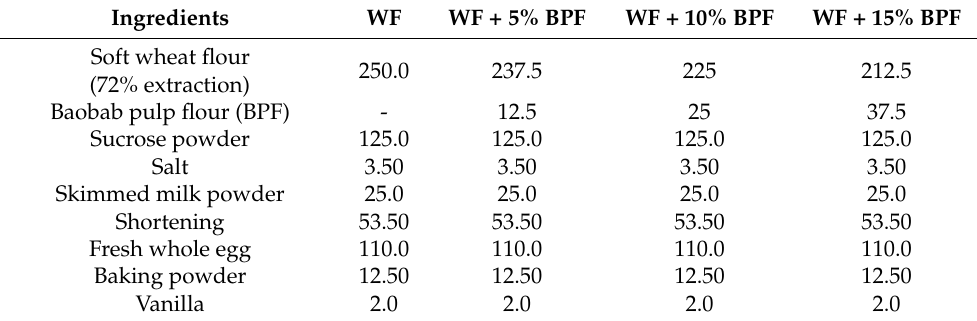
Table 1. Raw ingredients (g) of processed cake formulas substituted with BPF ( A. digitate ).